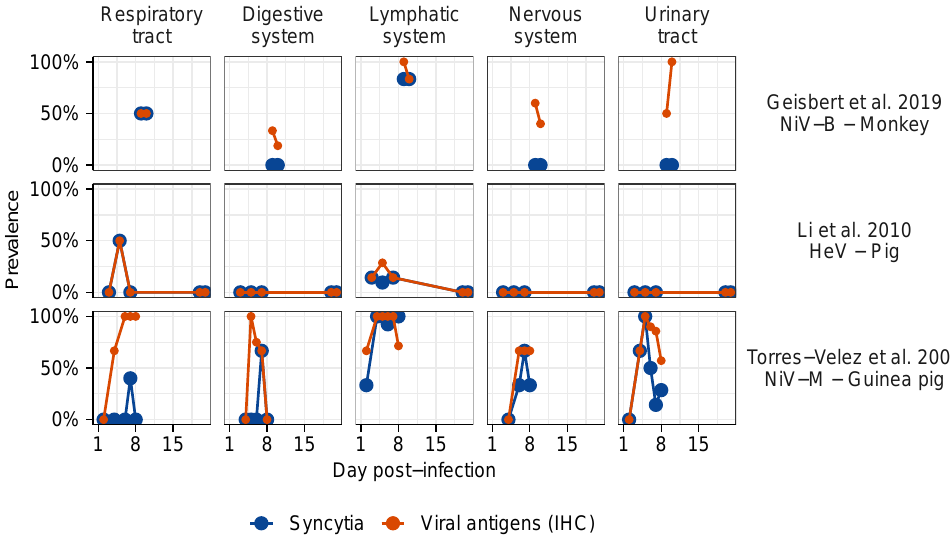
Figure 6. Proportion of individuals presenting syncytia and viral antigens detected by immunohisto- chemistry (IHC) over time post-infection following experimental henipavirus infection in vivo. Data from the most complete studies for each virus were selected. Data were extracted from [45,98,106]. The complete dataset showing the temporal patterns of syncytium detection is represented in Figures